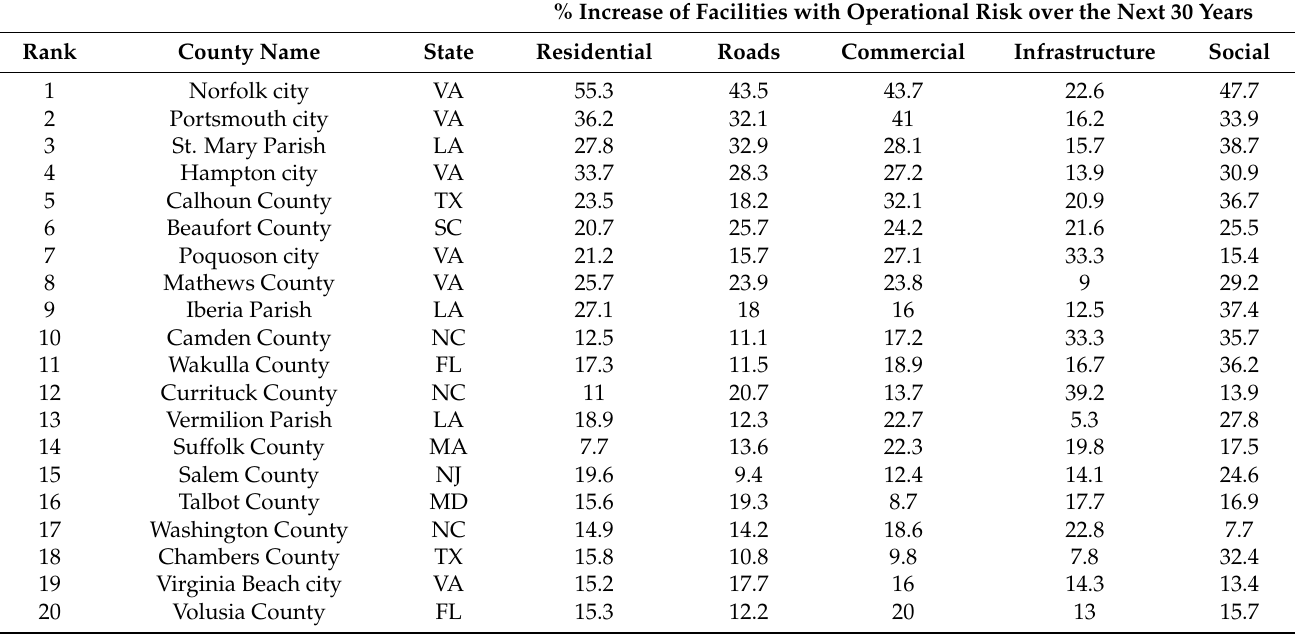
Figure 6. Overall risk change from 2021 to 2051 by county (change in percent of infrastructure with operational risk). Table 5. Top 20 “greatest change” in risk from 2021 to 2051 by county.